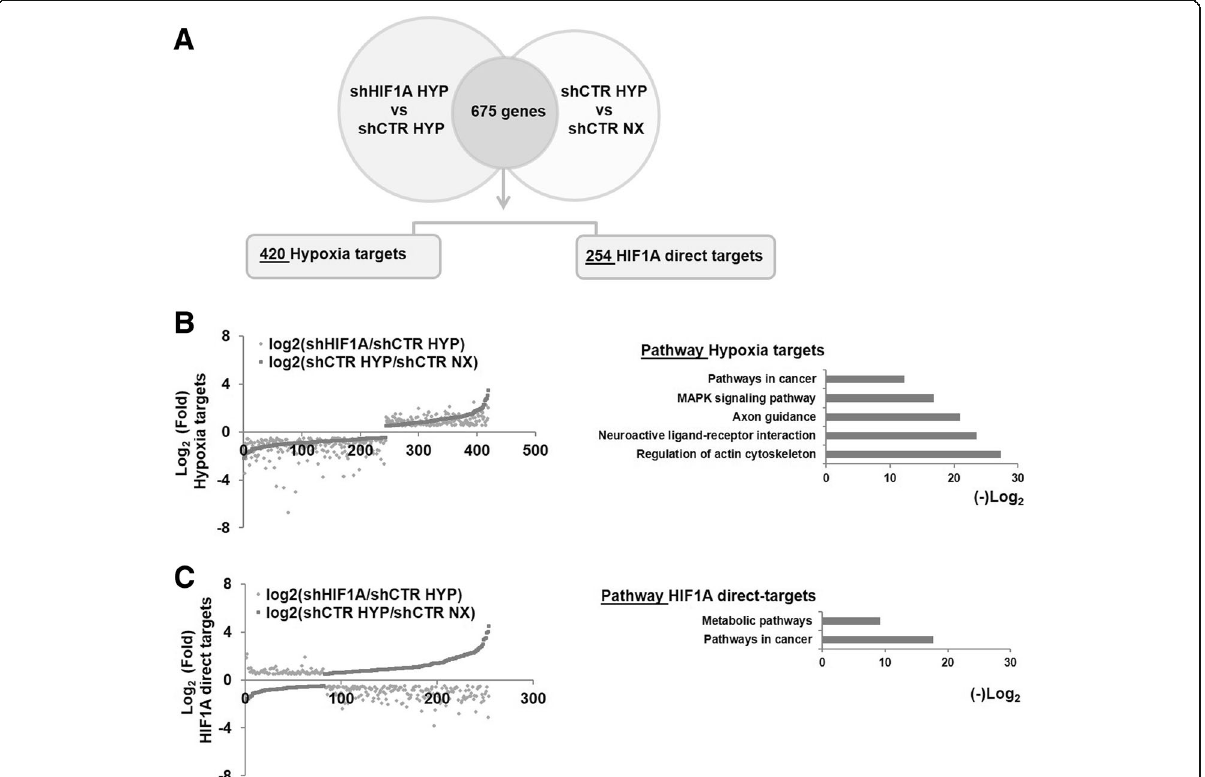
Fig. 2 Genes regulated upon hypoxia exposure, in presence and absence of HIF1A. a The differentially expressed genes in shHIF1A HYP vs shCTR HYP and shCTR HYP vs shCTR NX were crossed and 674 genes were found commonly regulated. Of note, 420 out of 674 genes show the same trend of regulation and are named Hypoxia targets; 254 out of 674 genes show an opposite regulation and are named HIF1A targets. b The fold change of Hypoxia targets expression (Log 2) in both gene lists is shown in the graph; KEGG pathways analysis ( p value ≤ 0.05) is reported and the negative Log 2 pvalue is shown on X-axis. c The fold change of HIF1A direct targets expression (Log 2) in both gene lists is shown in the graph; KEGG pathways analysis ( p value ≤ 0.05) is reported and the negative Log 2 pvalue is shown on